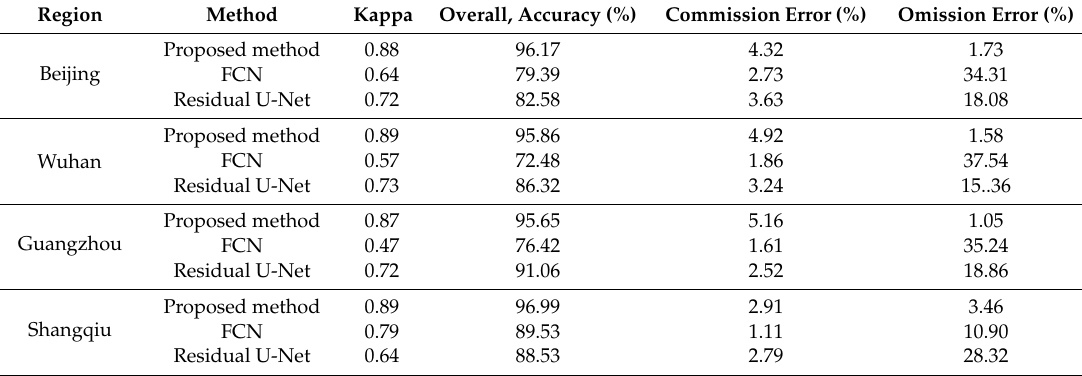
Figure 12. Extraction results of four regions based on three methods. Table 6. Accuracy evaluation of extraction results based on three methods.